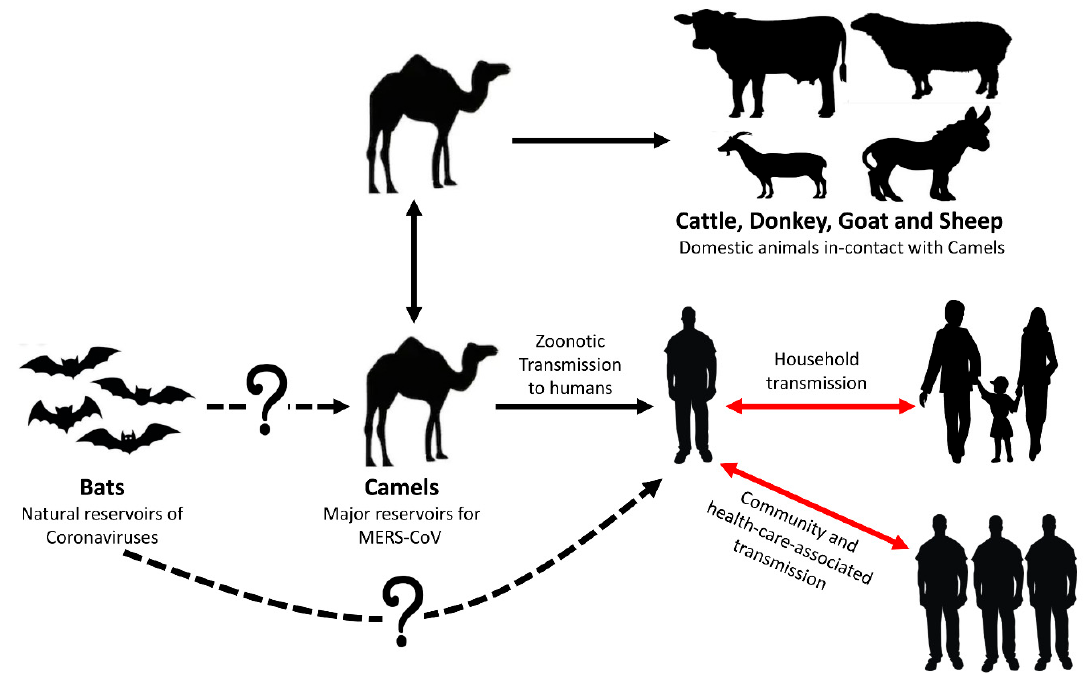
Figure 1. Zoonotic mode of transmission of MERS-CoV. The three routes of transmission (camel-to-camel, camel-to-human, and human-to-human) were confirmed. The prevalence of MERS-CoV in domestic animals in-contact with camels was recently identified [43]. As depicted by the dotted line, bat-to-camel and bat-to-human direct transmission of MERS-CoV have not been confirmed. Human-to-human transmission of the virus occurs after close contact with an infected case in households and healthcare settings (red arrows).